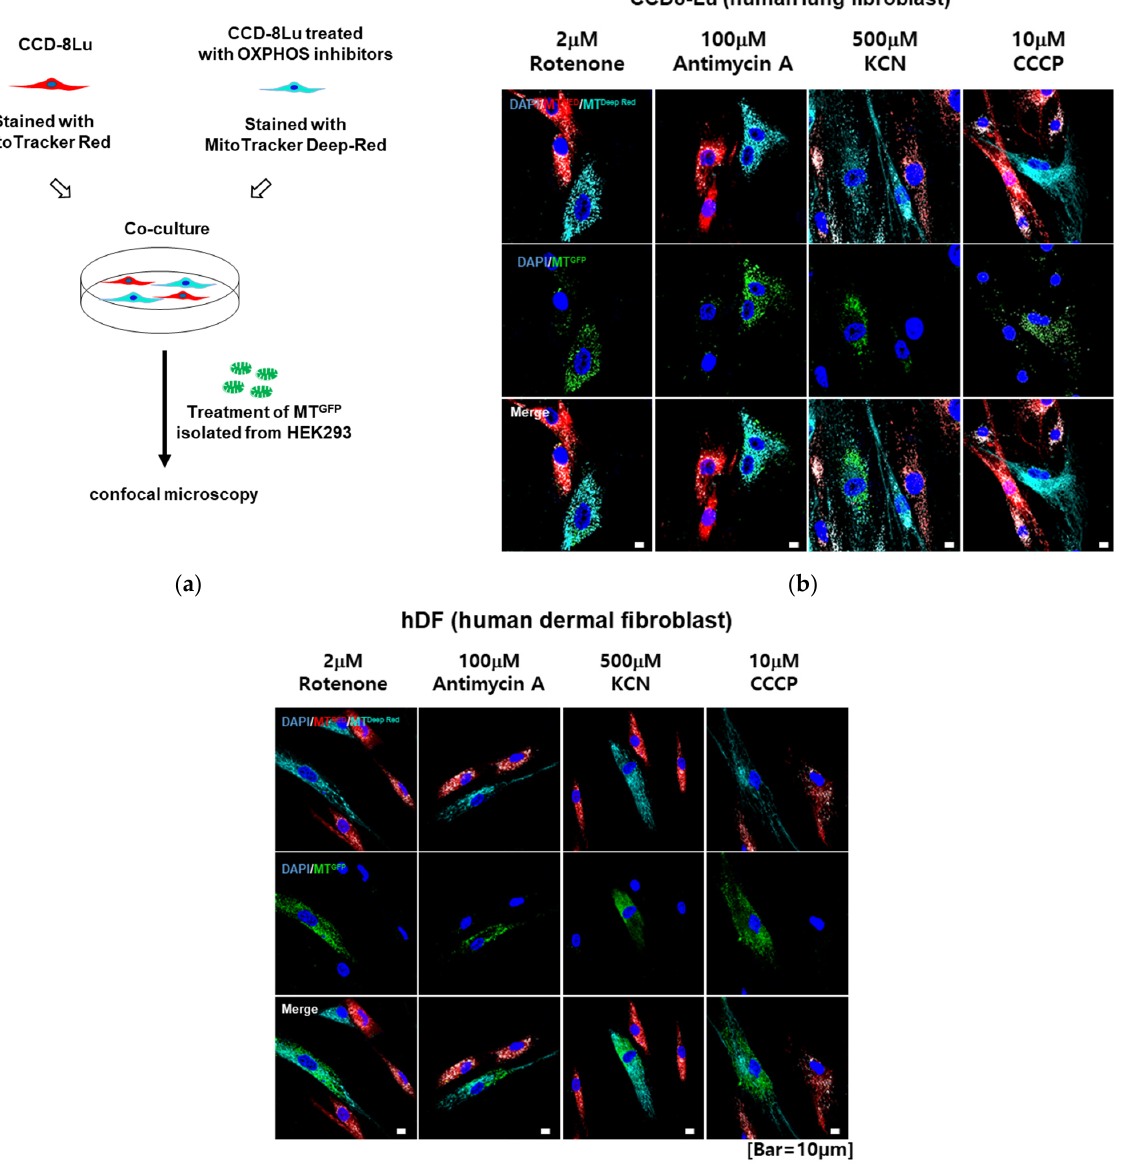
Figure 3. Preferential transplantation of MT GFP to human lung fibroblasts with mitochondria damage. ( a ) Coculture model of normal fibroblasts and fibroblasts with OXPHOS inhibitor-induced artificial mitochondria damage. These two fibroblast groups were prelabeled with MitoTracker Red CMXRos and MitoTracker Deep-Red, respectively, cocultured and treated with MT GFP . MT GFP was preferentially taken up by human lung fibroblasts ( b ) and human dermal fibroblasts ( c ) with damaged mitochondria. Cell nuclei were stained with DAPI (blue). Scale bar: 10 μ m.